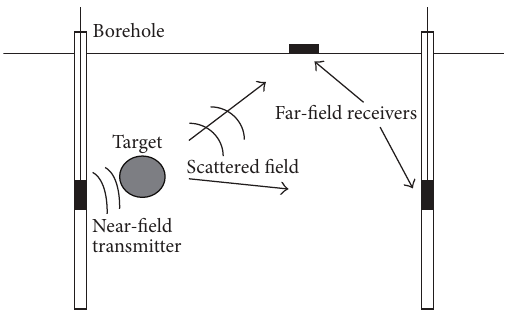
Figure 2: Subsurface sensing scenario involving near probing fields and far zone sensors. The multipole theory imaging approach of this paper is useful for imaging with either near or far